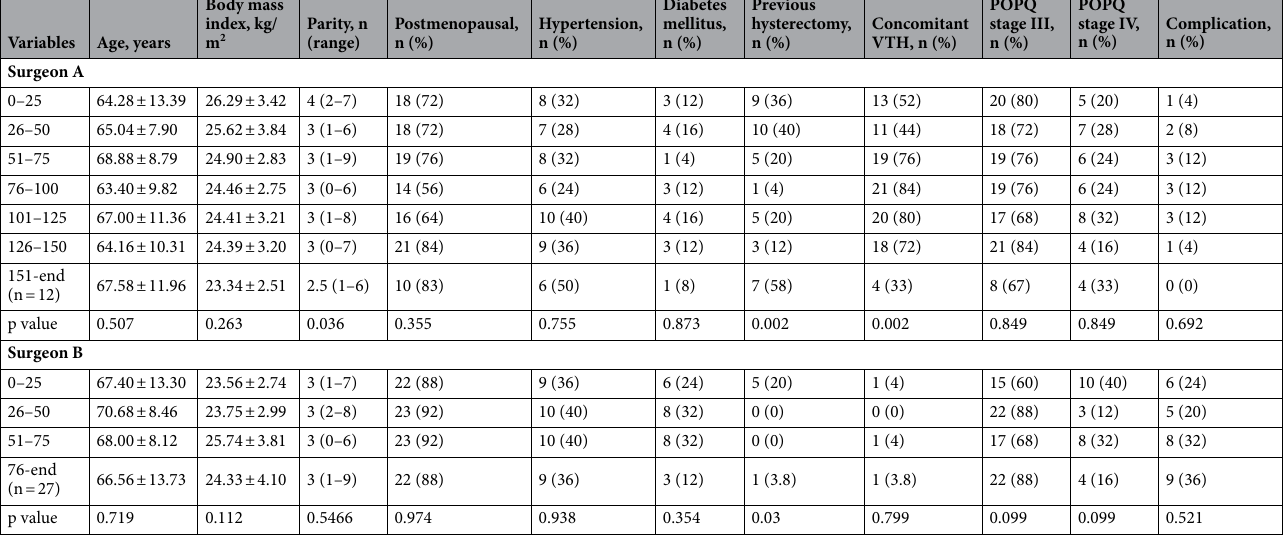
Table 2. Characteristics and procedures per 25 surgeries of surgeons A and B. Data are given as the mean ± standard deviation, median (range) and n (%); one-way analysis of variance, the Kruskal–Wallis test, Pearson’s Chi-squared test, and Fisher’s exact test were used to compare mean, median, and nominal variables between groups; post hoc tests were used in case of significance.